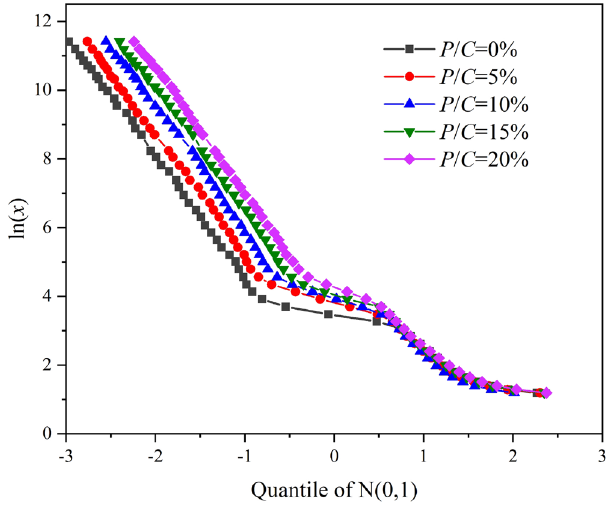
Figure 10. Q-ln plots for epoxy latex-modified mortar samples cured for 90